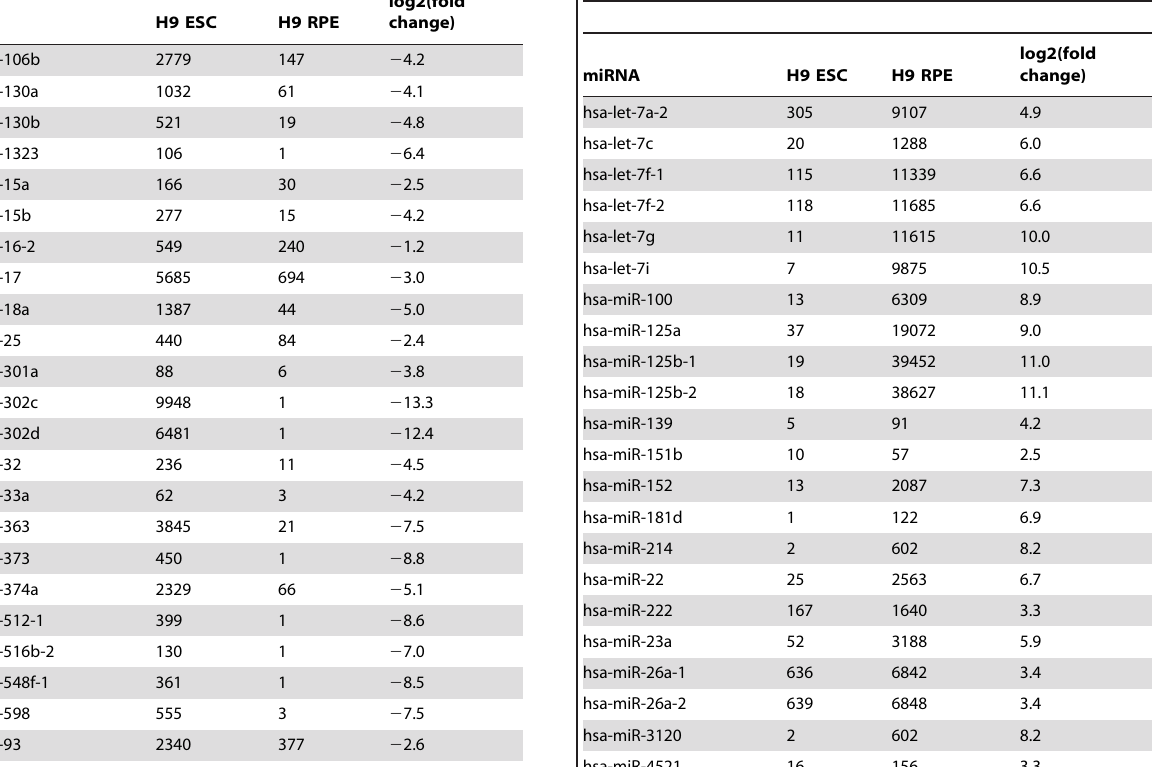
Figure 2. Select miRNAs are dynamically expressed during differentiation of H9 ES cell line. Representative miRNA expressions that are A) down-regulated or B) up-regulated during the course of differentiating H9 ESCs. All values were normalized to ES state, then log2 transformed. C) RT-PCR analysis of different RPE differentiation stage showing miR-23a, miR125a, miR-125b, miR-302d and let-7g expression relative to H9 ESC stage. The relative expression levels for each miRNA were normalized by hsa-U6 control. PD = partially differentiated, PC = pigmented clusters, ES =